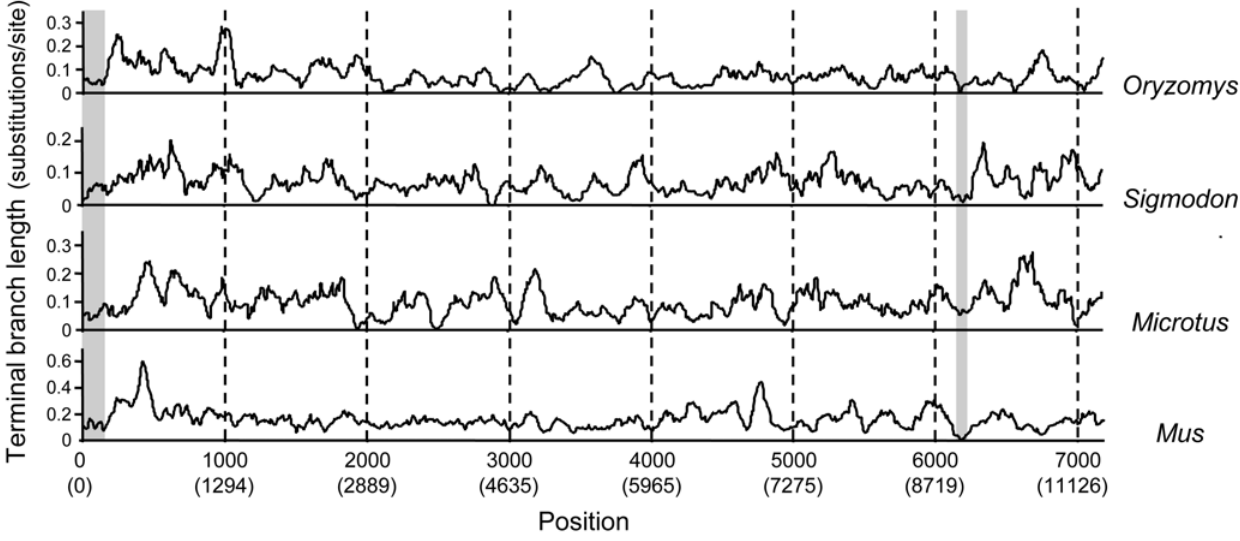
Figure 4. Sliding window analysis of terminal branch lengths of Xist in four rodent species. Likelihood trees were determined for 100 bp windows with a 10 bp slide between each window. The terminal branch length in each window for each species was then plotted. The upper numbers on the X axis indicate the position in the data matrix used for this analysis (see Supplementary Sliding Window file). The lower numbers in parentheses indicate the position in the original alignment before gaps and areas with ambiguous alignment were removed (see Supplementary Alignment file). The shaded areas show two selected regions with short branch lengths in all four species. doi:10.1371/journal.pone.0006252.g004 PLoS ONE |